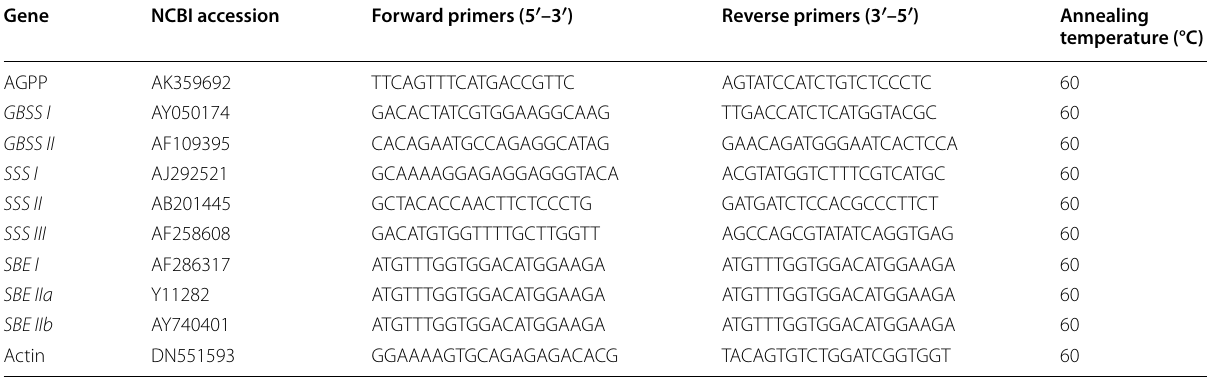
Table 1 Primer sequence for starch synthesis related gene